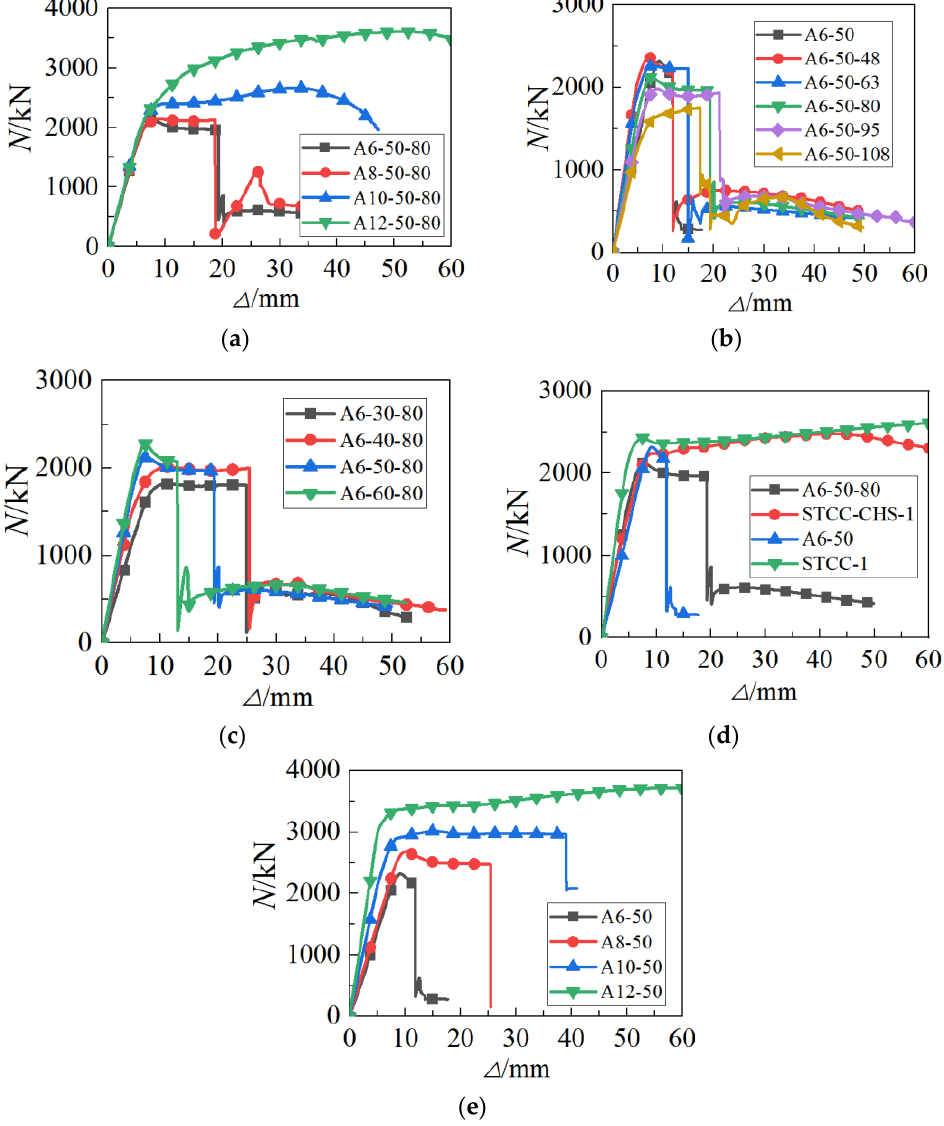
Figure 6. N - Δ relationships. ( a ) Diameter – thickness ratio, ( b ) hollow rate, ( c ) concrete strength, ( d ) Figure 6. N - ∆ relationships. ( a ) Diameter–thickness ratio, ( b ) hollow rate, ( c ) concrete strength, material of the outer tube, and ( e ) ATCC. ( d ) material of the outer tube, and ( e )